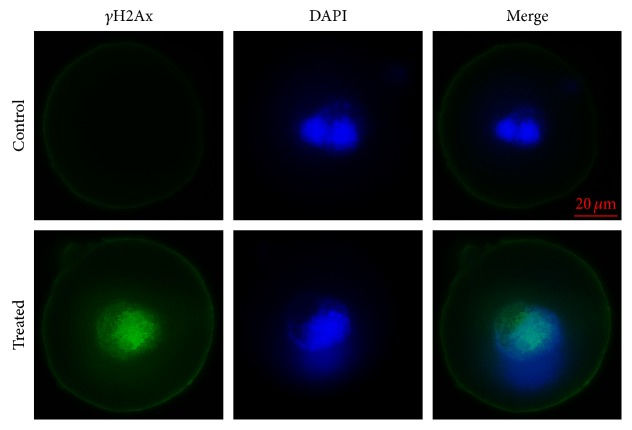

γH2AX detection in mouse zygotes at 17 hpi. Nuclei were stained with DAPI (blue). γH2AX staining was detected in the nuclei of H2O2-treated embryos, but not in those of the control group.